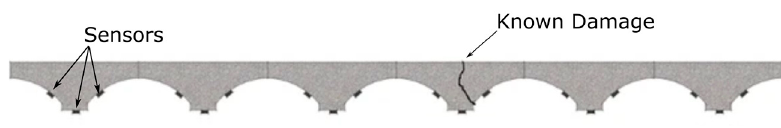
Figure 7. Qatar University grandstand simulator [146]. 2.6. Los Alamos National Laboratory Three-Story Frame Structure The Los Alamos National Laboratory (LANL) three-story frame structure consists of four aluminum plates and four aluminum columns, with the plates only permitted to move in the x- direction (Figure 8). Additionally, a central column that is connected to the top plate is added to simulate the damage to the structure as it induces nonlinearity to the structure’s behavior. The structure’s dynamic response is measured using four accelerom- eters attached to the center of each plate. The testing scenarios can be mainly classified into four main groups. The first one represents the baseline where the structure is consid- ered undamaged. The second one is set to simulate the environmental and operational conditions which are performed by changing the columns’ stiffnesses and masses. The damage is simulated in the third group by using the bumper to introduce the nonlineari- ties to the structure. Finally, the last group is a combination of the last two groups together to simulate both the damage and the environmental change [148].